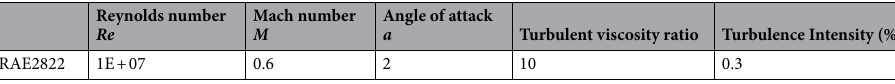
Table 1. Simulated parameters for the test case.